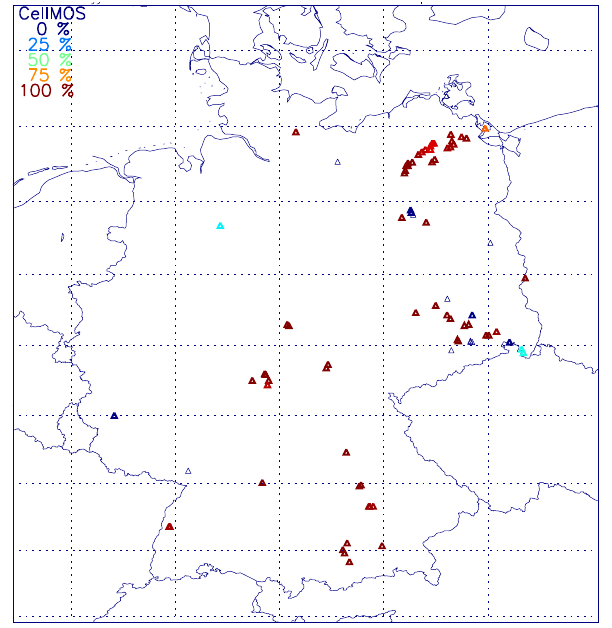
Figure 4. CellMOS analysis probability for hail larger than 15mm (thick blue and red triangles) for all QC1 and QC2 hail entries (sum- mer 2010) in the ESWD. Thin triangles show hail reports with no CellMOS cell within 20km and ±